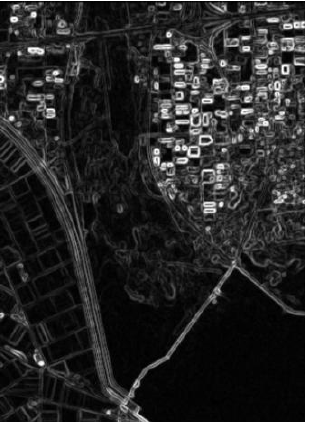
Figure 3d. Gallikos river, Sobel operator